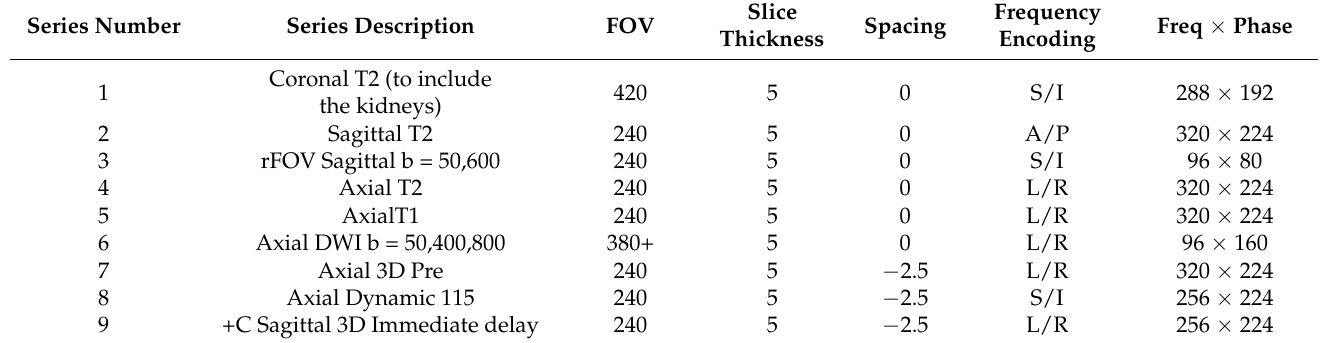
Table 1. Protocol of pelvic MRI.